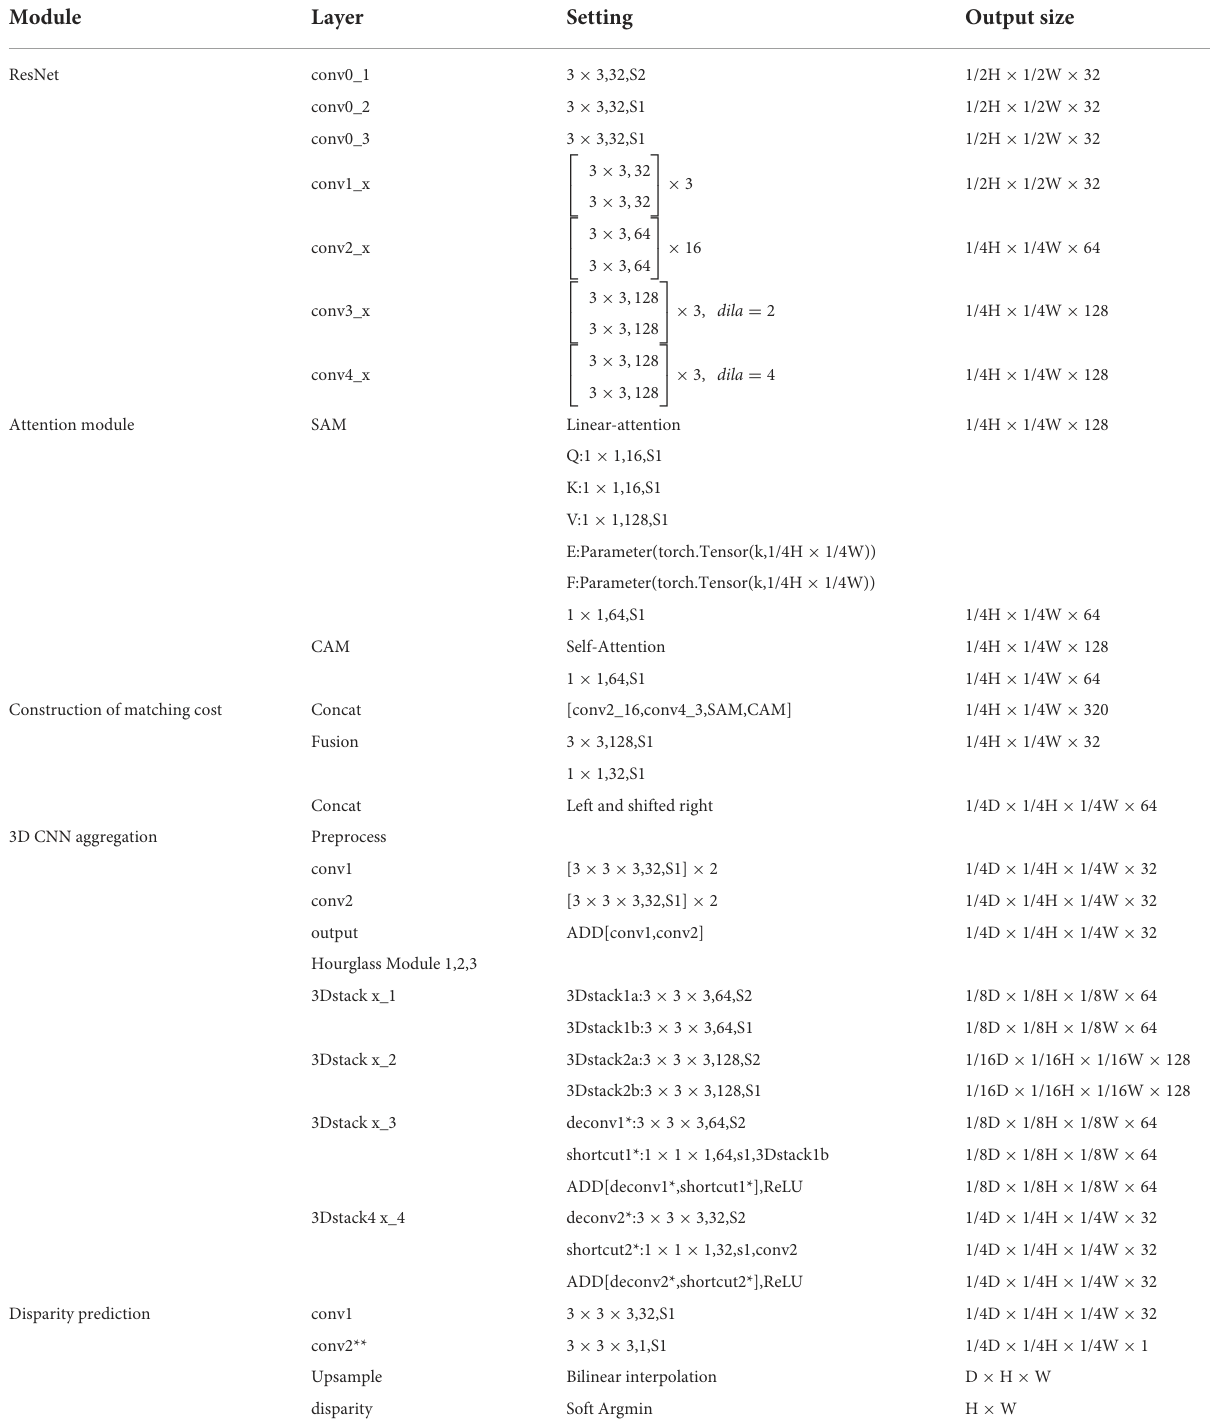
TABLE 1 Layers and parameter settings of the proposed LANet. Module Layer Setting Output size